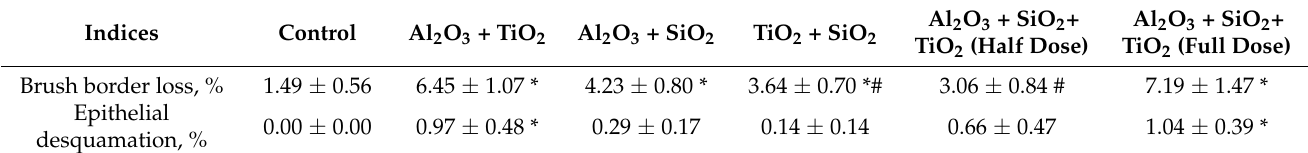
Table 2. Morphometric indices of damage to the epithelium of proximal convoluted tubules in rat kidneys following subchronic exposure to binary and ternary mixtures of Al 2 O 3 , TiO 2 , and SiO 2 nanoparticles (X ± Sx).